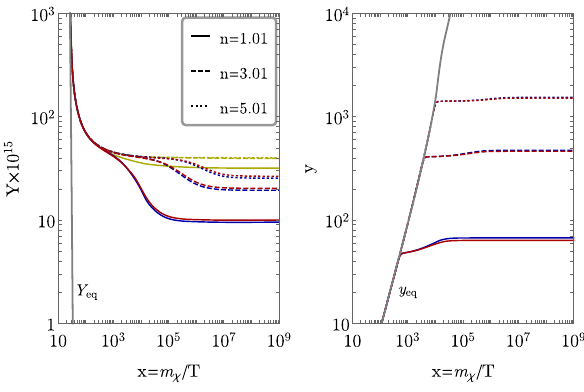
Fig. 6 Evolution of DM abundance Y ( x ) (left) and velocity dispersion y ( x ) (right) for the Sommerfeld model, with α χ and m χ as in Fig. 5. Line colors correspond to nBE (green), cBE (blue) and fBE (red). Line styles refer, as indicated, to different values of m A , chosen such that n 2 = 6 α χ m χ /(π 2 m A ) is close to integer (parametric resonance condition). The second annihilation era characteristic for these models is clearly visible as a drop of Y in the left panel; the corresponding increase in the DM temperature visible in the right panel is caused by a self-heating due to efficient annihilation out of thermal